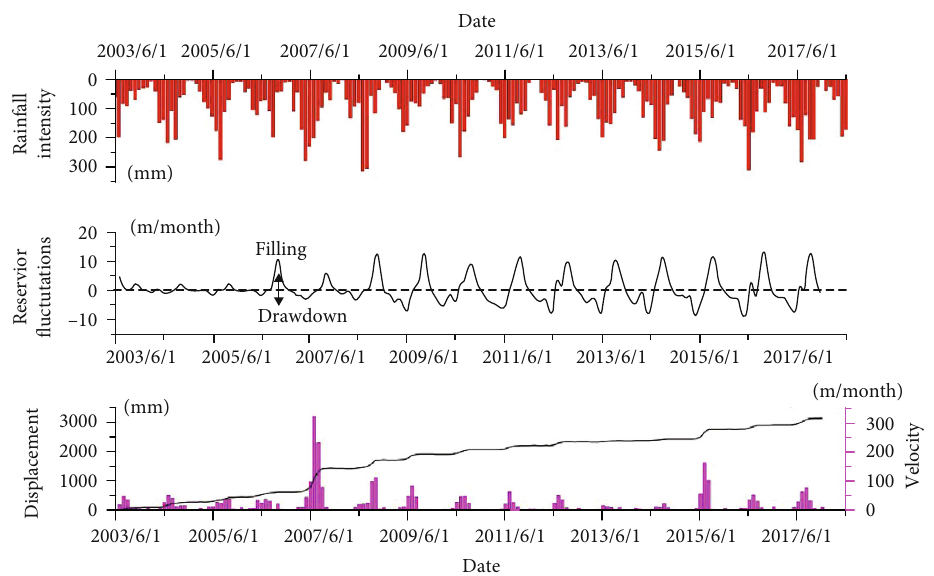
Figure 3: Time series of rainfall intensity, reservoir fl uctuation, cumulative displacement, and displacement velocity from the Baishuihe Landslide area spanning the period from June 2003 to December